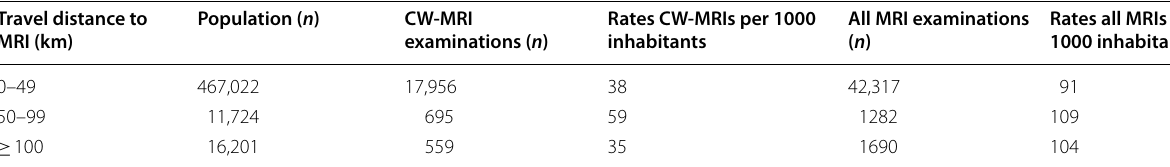
Number of inhabitants within various distance ranges to the nearest MRI facility, the number of all MRIs and CW-MRIs, and rates per 1000 inhabitants for CW MRI- examinations and all MRI examinations